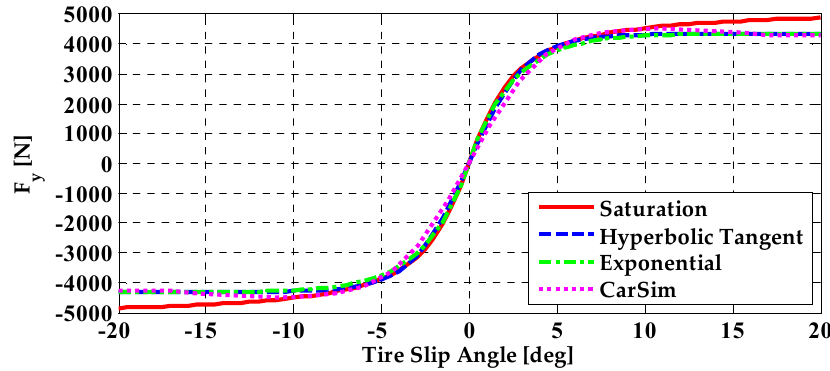
Figure 3. Fitting results of lateral tire force models for CarSim data.